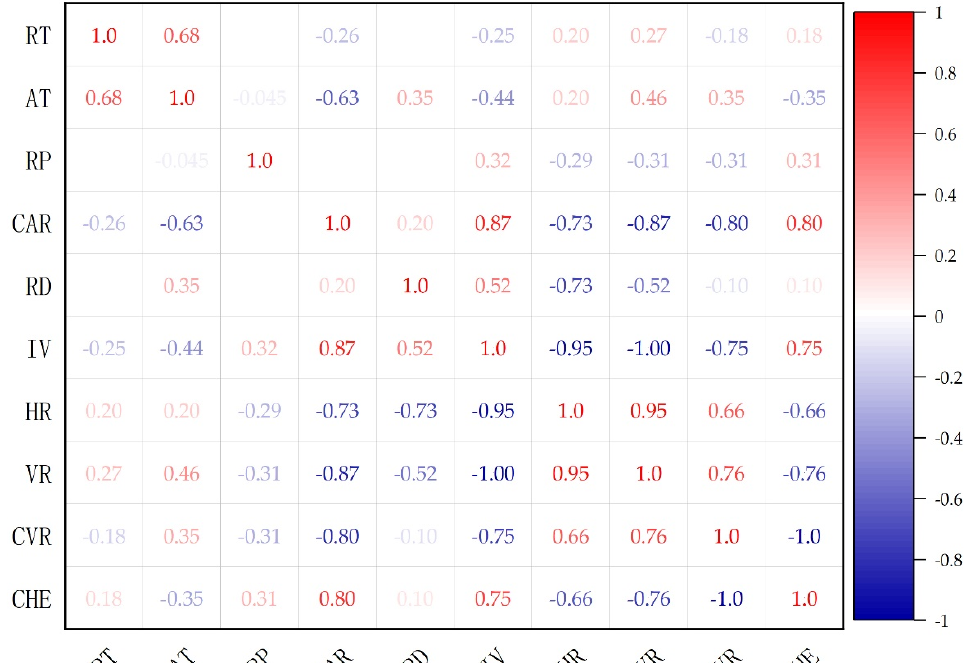
Figure 4. Linear fitting result diagram.